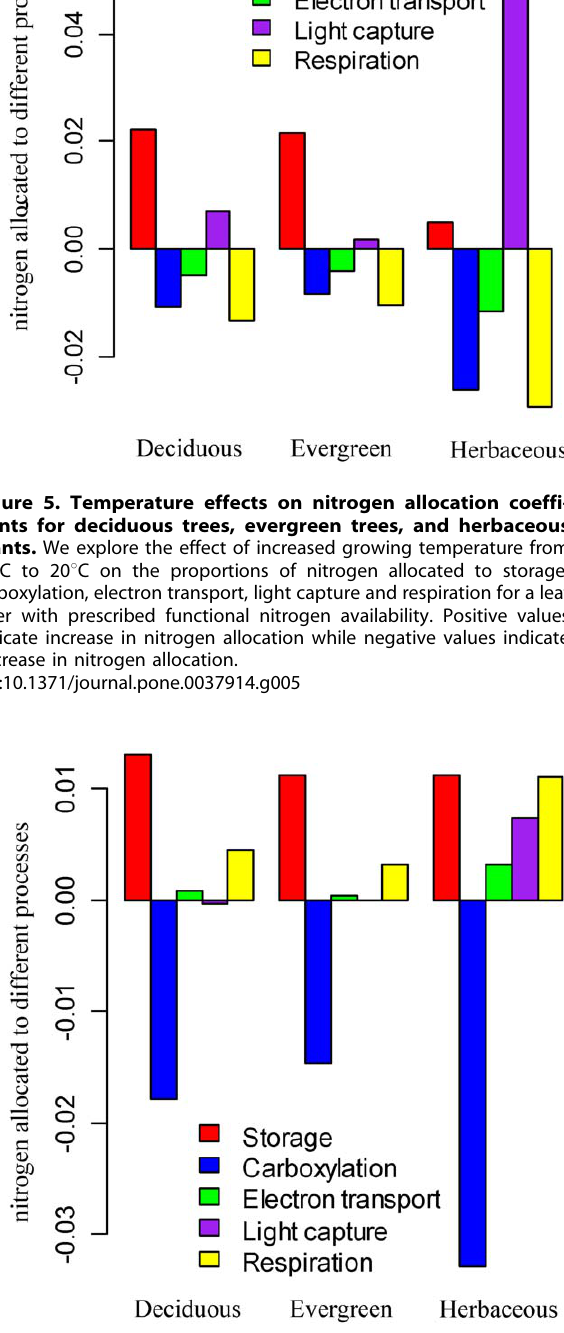
Figure 6. Effects of elevated CO 2 concentration on nitrogen allocation coefficients for deciduous trees, evergreen trees, and herbaceous plants. We explore the effects of increased CO 2 concentration from 370 ppm to 570 ppm on the proportions of nitrogen allocated to storage, carboxylation, electron transport, light capture and respiration for a leaf layer with prescribed functional nitrogen availability. Positive values indicate increase in nitrogen allocation while negative values indicate decrease in nitrogen allocation.